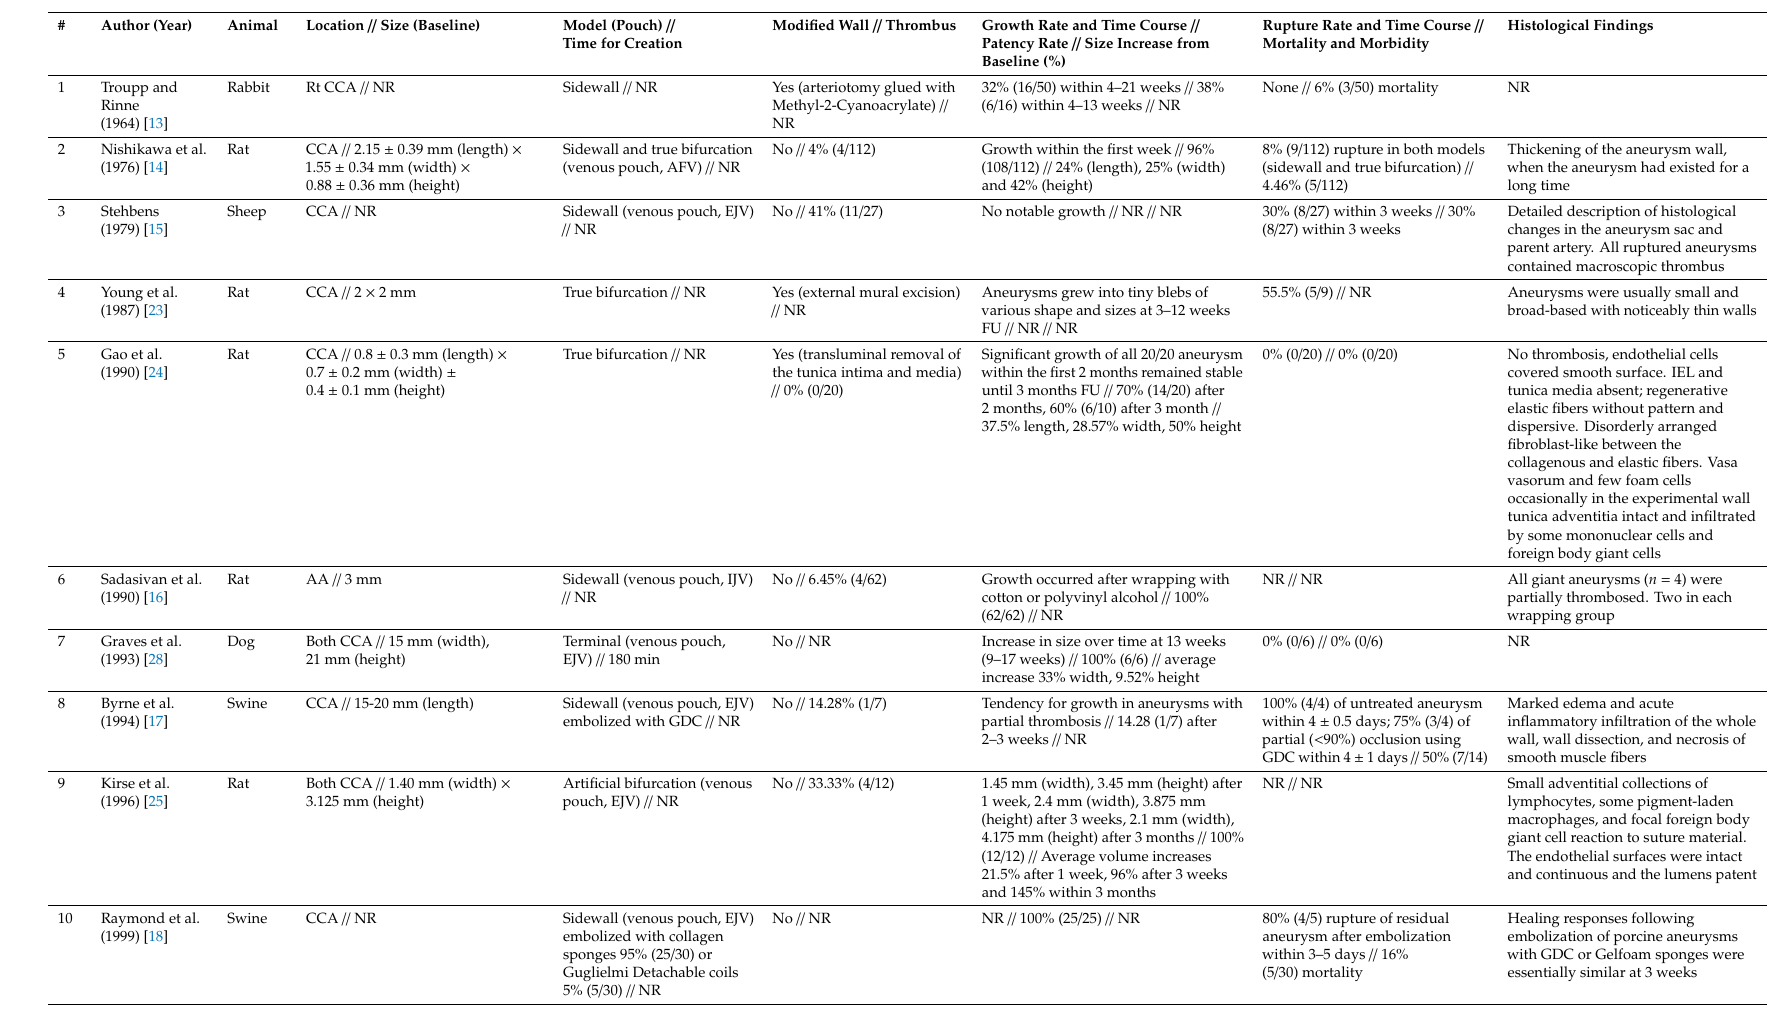
Table 1. Detailed characteristics of aneurysm models featuring growth and